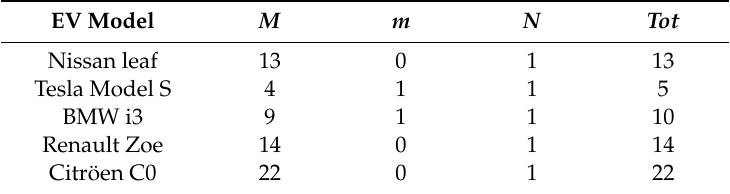
Table 9. Sizing of shared II-Life ESS for CSs by using di ff erent battery packs. EV